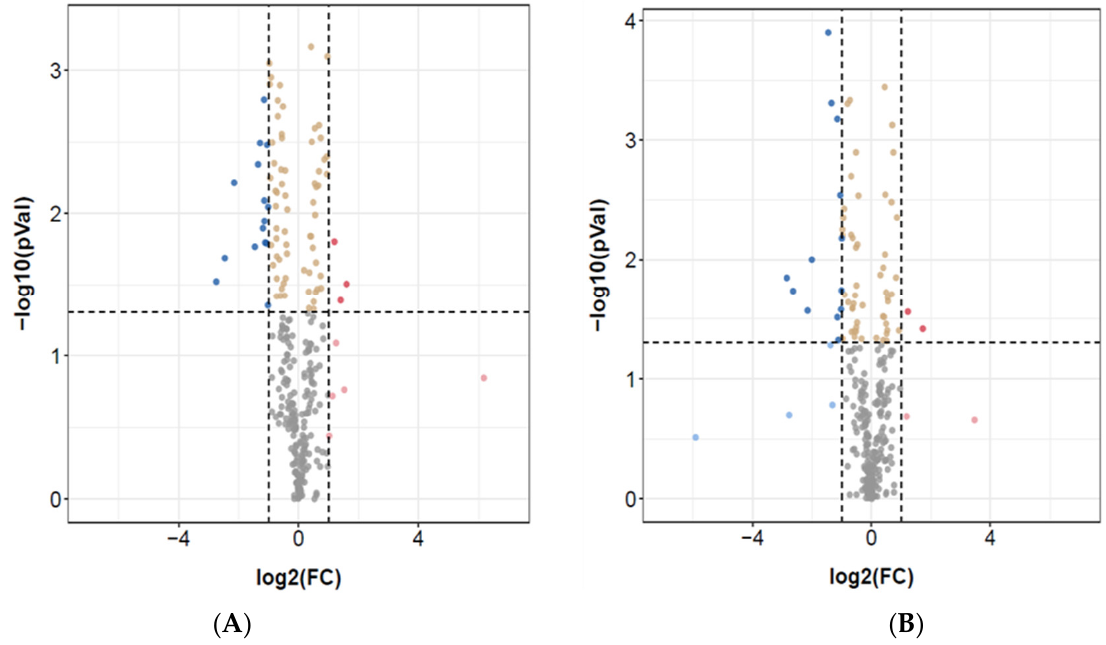
Figure 1. Differential expression of miRNAs in LCL groups. ( A ) Volcano plot of differentially expressed miRNAs in ASD and control LCLs. ( B ) Volcano plot of differentially expressed miRNAs in ASD and Siblings LCLs. The red dots are up-regulated, and the blue dots are down-regulated; the gray dots denote no change; the yellow dots are not significant. n = 9–10 in each group. To determine significant genes (red and blue color dots), the p -value cut-off was set to 0.05.